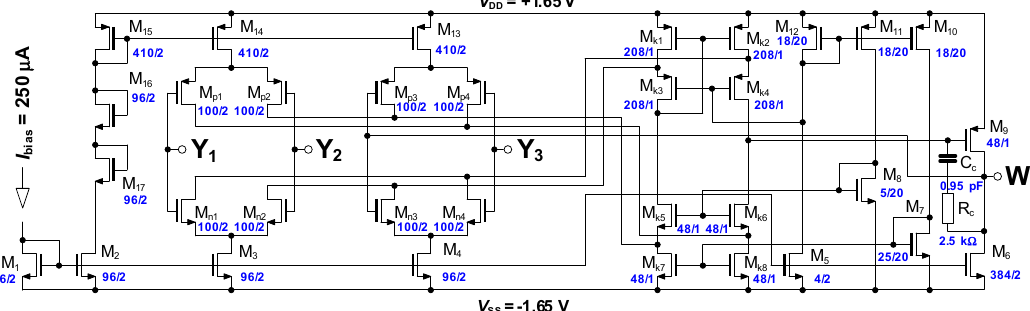
Figure A1. Full CMOS topology of the voltage differencing differential buffer (VDDB).